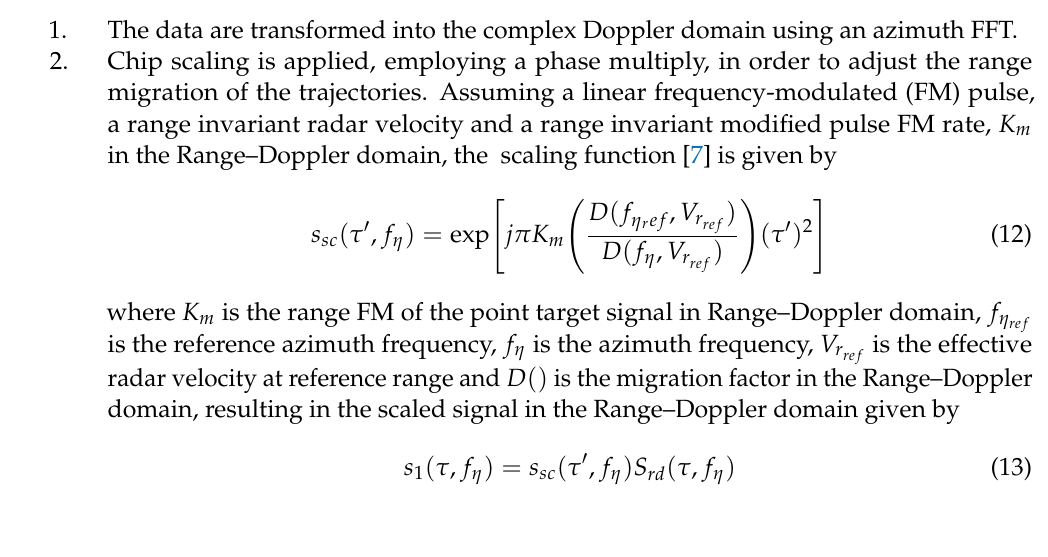
Figure 5. Block diagram of the chirp scaling algorithm, from